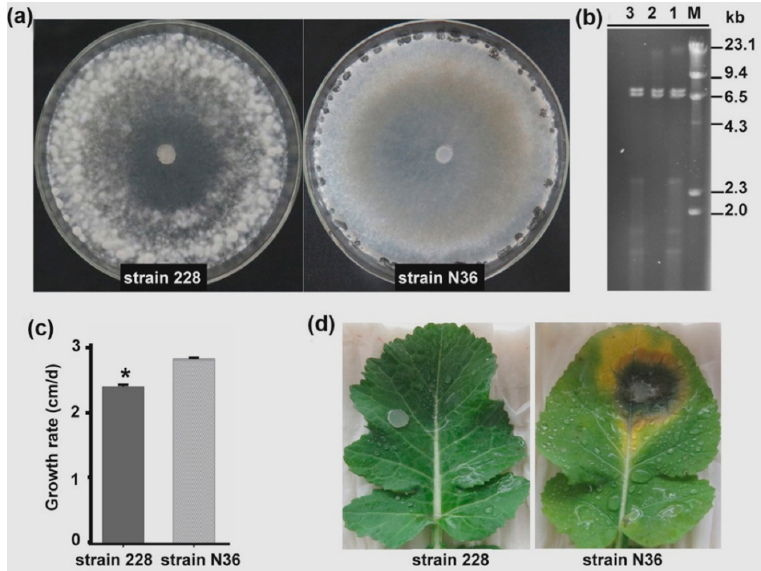
Figure 1. Biological characteristics of S. sclerotiorum strain 228 and its dsRNA elements. ( a ) Colony morphology of strains 228 and N36 (virus-free) grown on PDA for 7 days at 20 °C; ( b ) Double-stranded RNA elements in strain 228. Lane 1, untreated dsRNA; Lane 2, dsRNA treated with S1 nuclease; Lane 3, dsRNA treated with DNase I, prior to electrophoresis; ( c ) Growth rate of two S. sclerotiorum strains. Values that are significantly different ( p < 0.05) are indicated by asterisks; ( d ) Assay of the virulence of strains 228 and N36 on detached rapeseed leaves at 72 h post-inoculation at 20 °C and 100% relative humidity.